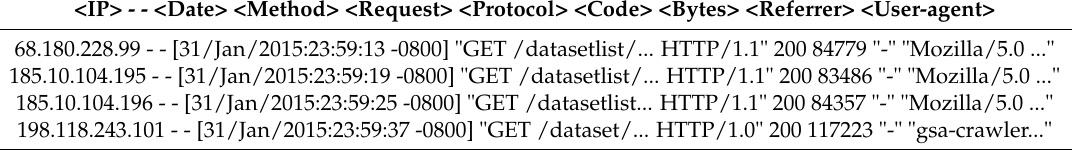
Table 1. Sample HTTP log data in Combined Log